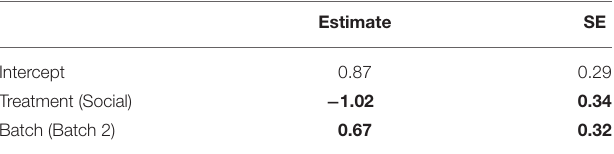
TABLE 2 | Estimates and standard errors (SE) from a generalized linear model (GLM) examining the effects of a lizard’s treatment group (social learning